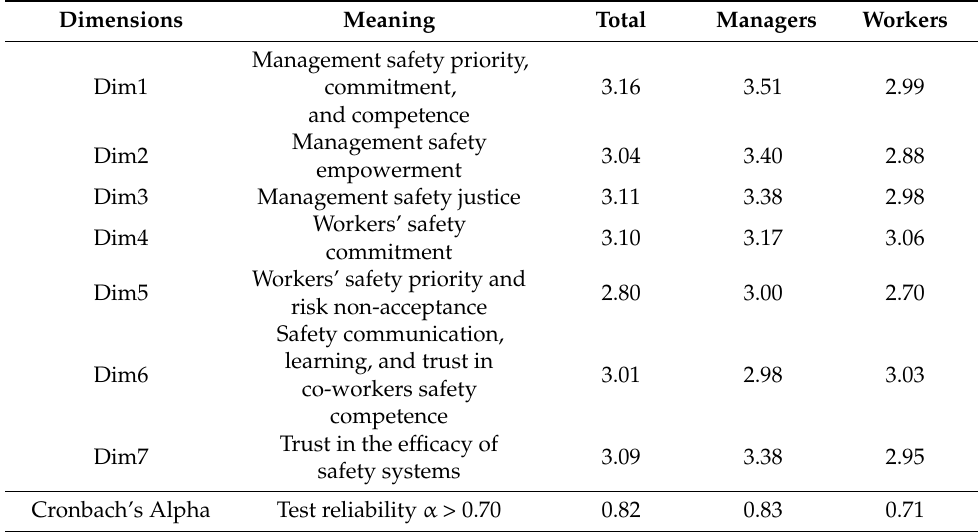
Table 5. Scores of NOSACQ-50 divided per dimensions (expressed as mean values) and the related Cronbach’s Alpha indexes.